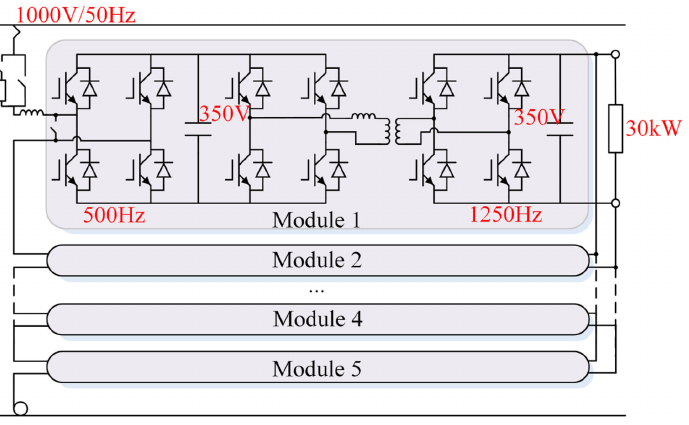
Figure 15. Two-stage SST with a CHBC and output-paralleled DAB converters